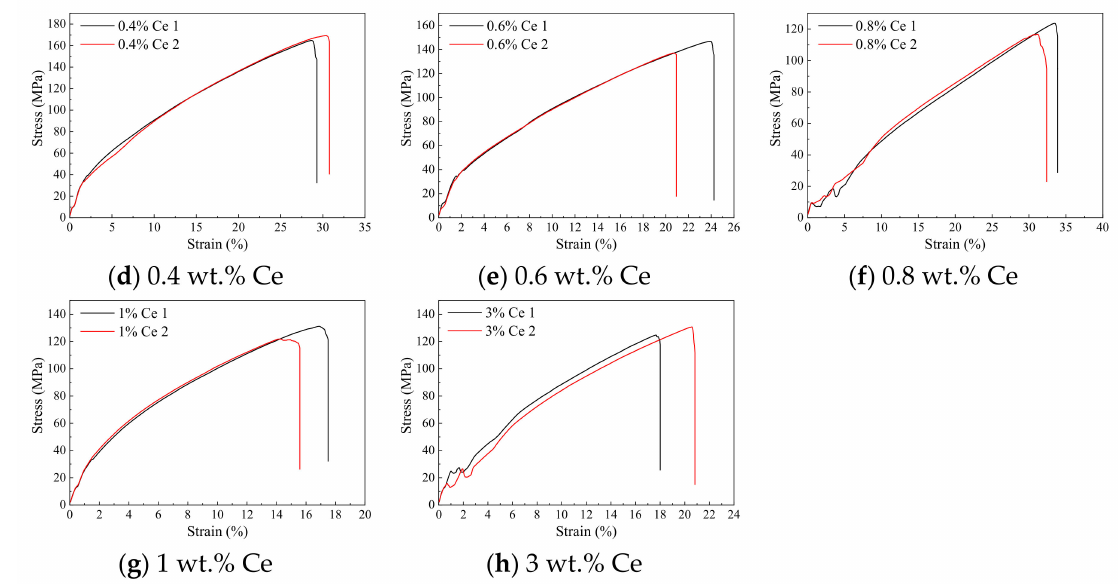
Figure 8. Tensile curves of the samples with different Ce contents at ambient temperature.